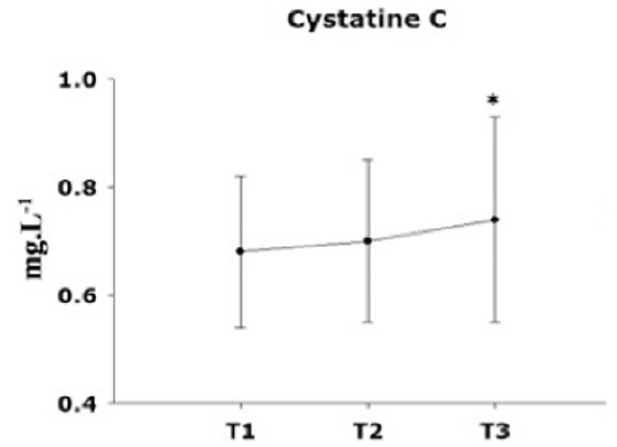
Figure 3 - Cystatin C in mg.L -1 (mean ¡ standard deviation) at baseline (T1), 30 minutes after abdominal insufflation (T2), and 30 minutes after the end of the pneumoperitoneum (T3). * p , 0.05 versus baseline